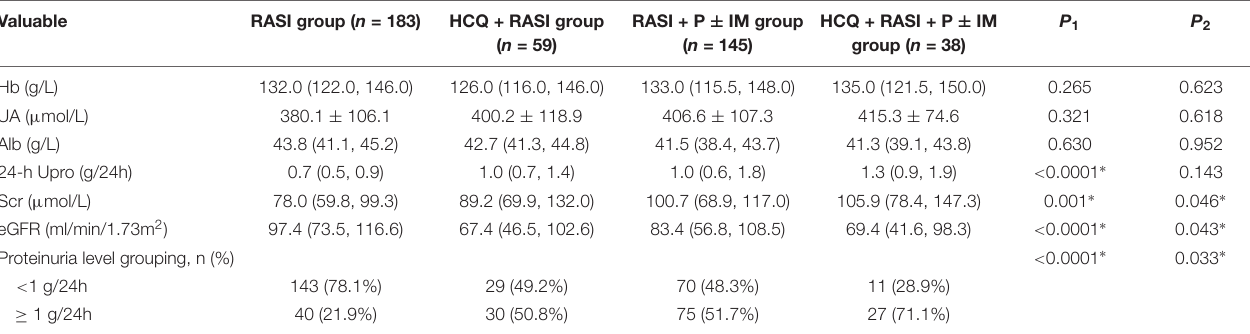
TABLE 2 | The clinicopathological characteristics of IgAN patients with residual proteinuria after at least 6 months of traditional treatment at the enrollment.